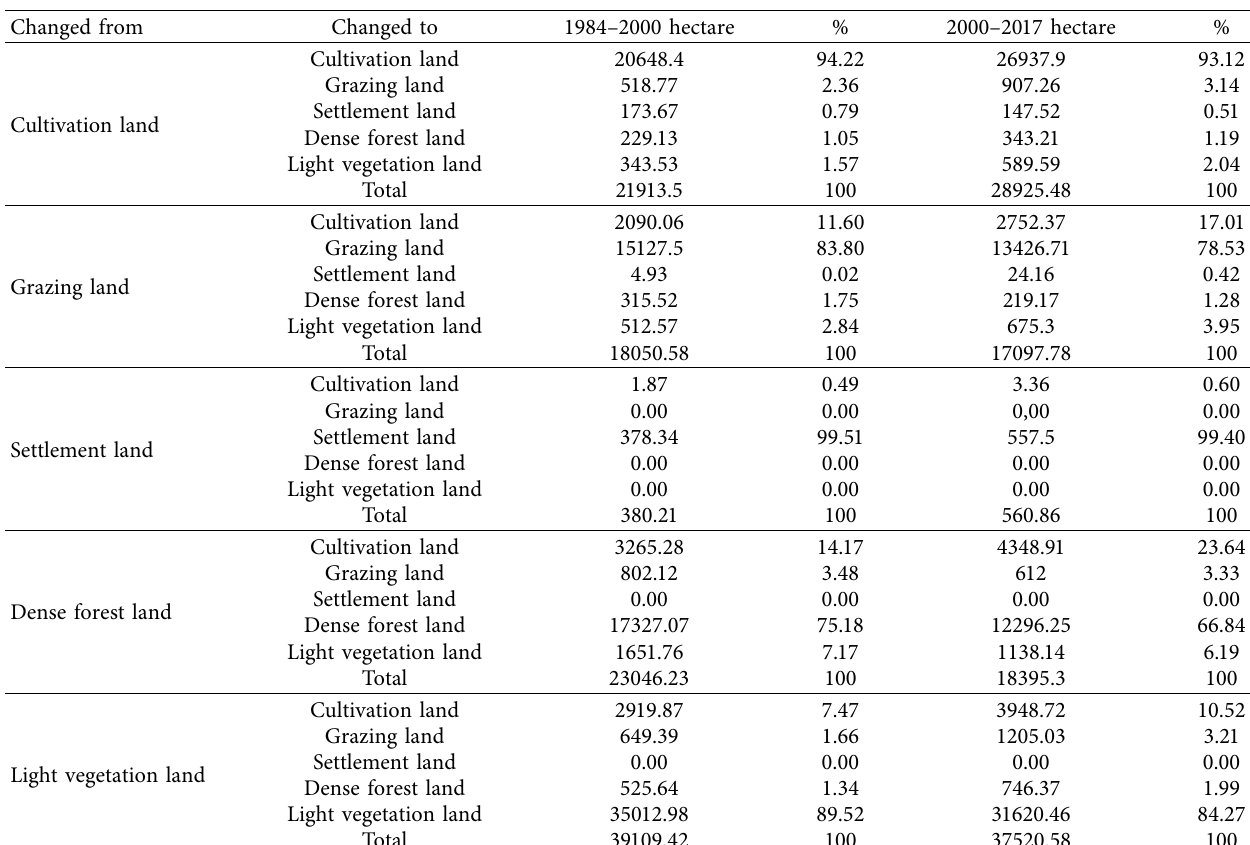
Table 3: LULC transformation matrixes in different periods (area in hectare and %). Changed